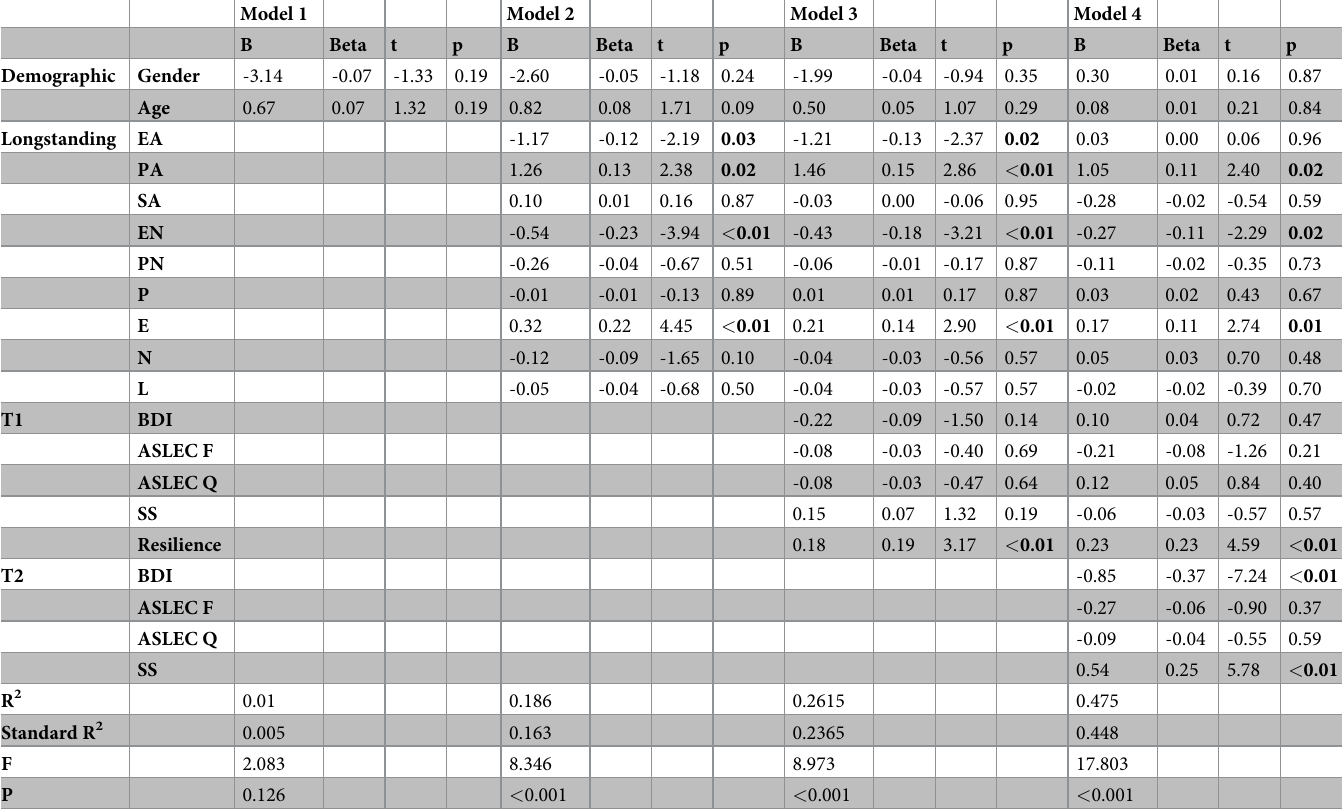
Table 4. Hierarchical linear regression for T2